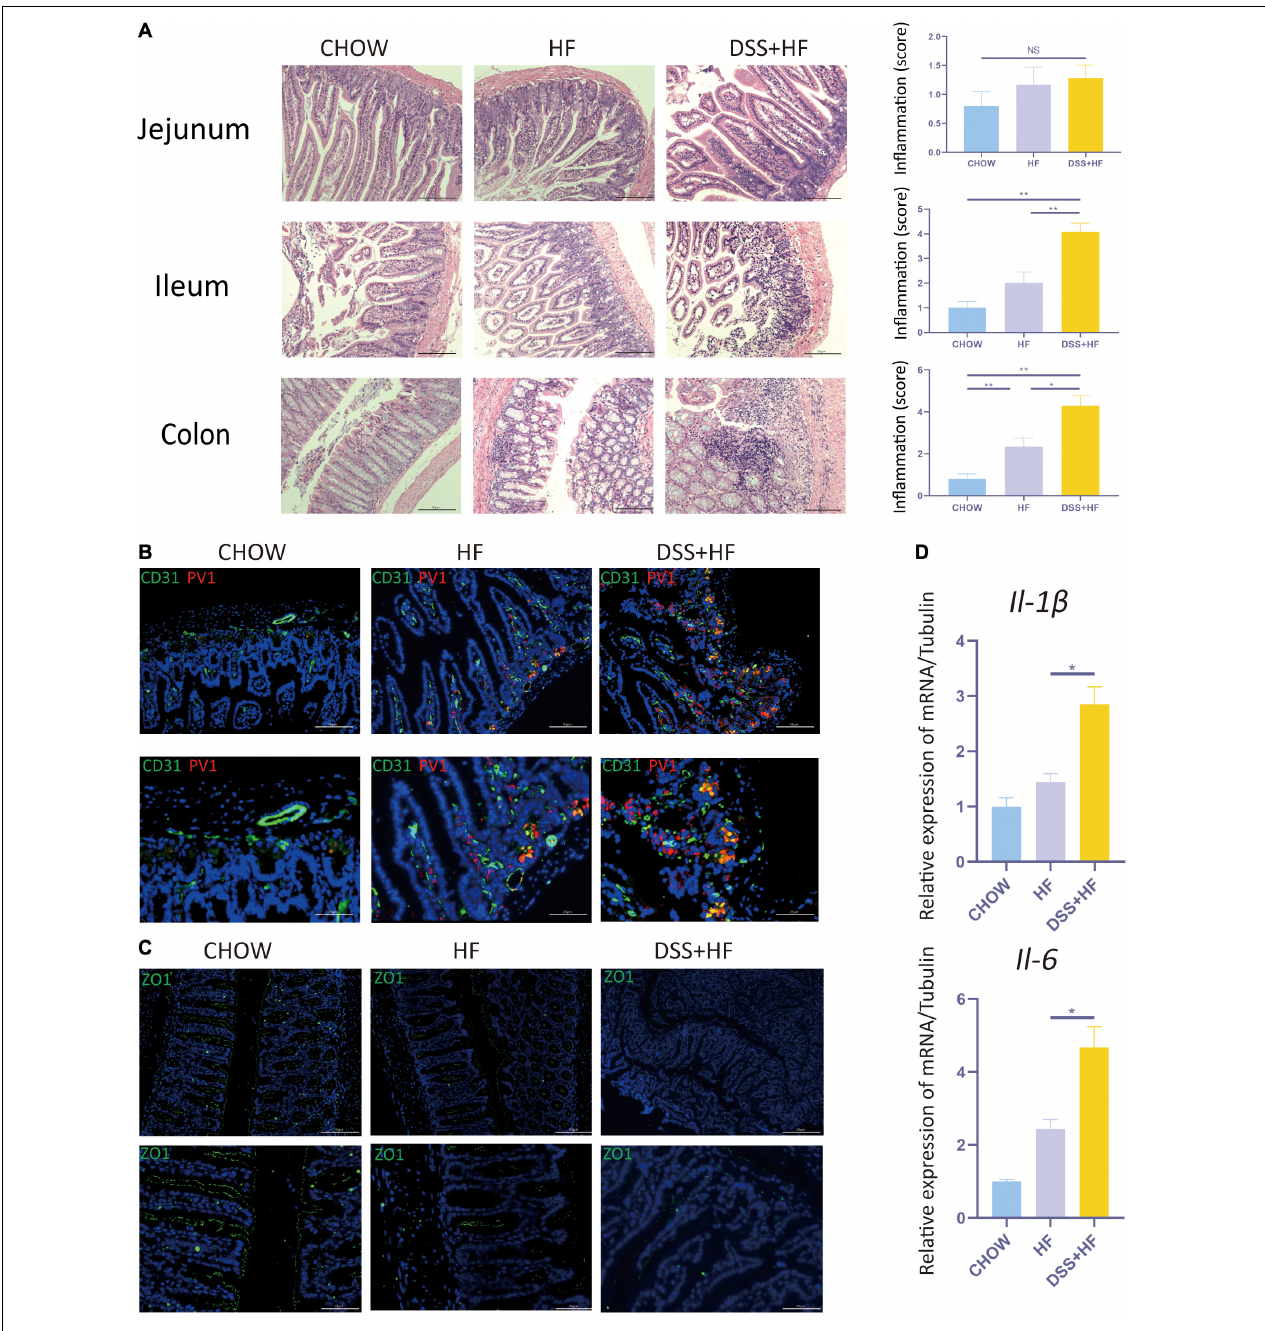
FIGURE 2 | Dextran sulfate sodium salt administration enhances intestinal inflammation and the disruption of gut-vascular barrier and intestinal barrier in mice with NASH. (A) Representative images of jejunum, ileum, and colon in chow, HF, and DSS + HF group; The statistical analysis of inflammation score. The data are expressed as the mean ± SEM. NS, not statistically significant; * P < 0.05; ** P < 0.01. (B) Representative IF images indicating co-localization of PVl (red) with CD31 (green) in colon from chow, HF, and DSS + HF group. (C) Representative IF images of Z0-1 (green). (D) II-1 β and II-6 expression at the mRNA level in colon from the above groups. * P <